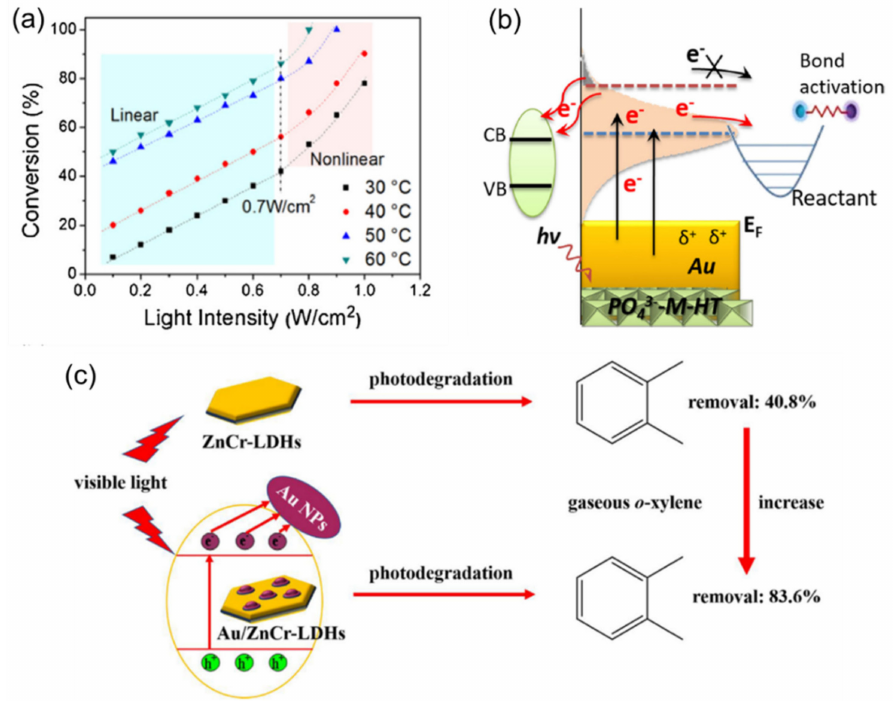
Figure 10. ( a ) Temperature-dependent photocatalytic efficiency as a function of light intensity, ( b ) Schematic illustration of the electron transfer mechanism in Au/PO 43 − -M-HT under irradia- tion (Reprinted from [107] with permission of Elsevier, 2017) and ( c ) Schematic representation of mechanism and photocatalytic efficiency in volatile gaseous compounds removal by Au/ZnCrLDH (Reprinted from [42] with permission of Elsevier,